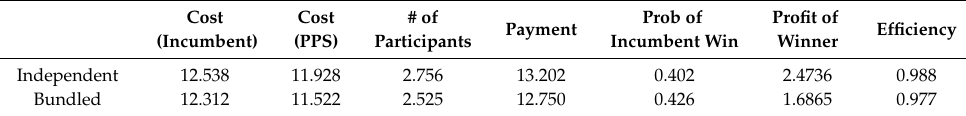
Table 6. Expected values for independent vs. bundled auctions (case